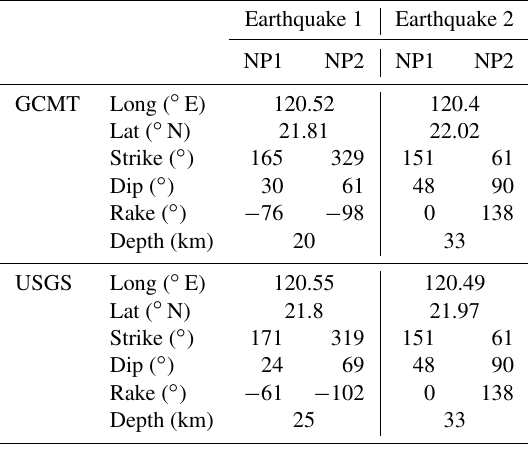
Table 2. Focal mechanisms for successive earthquakes estimated by GCMT and